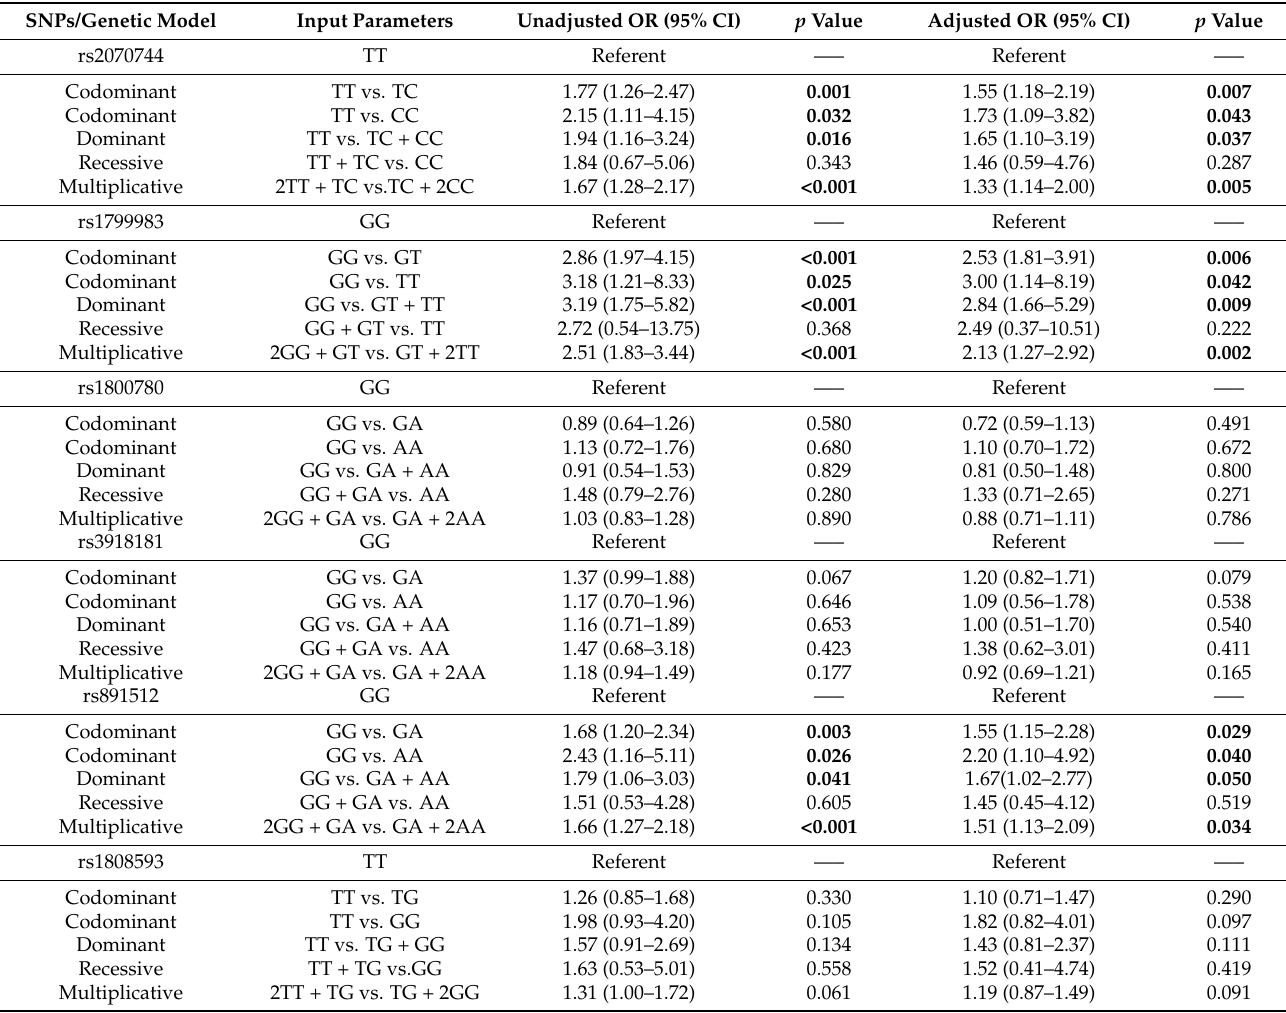
Table 3. Association of eNOS gene SNPs for the endothelial dysfunction associated osteoporosis risk. SNPs/Genetic